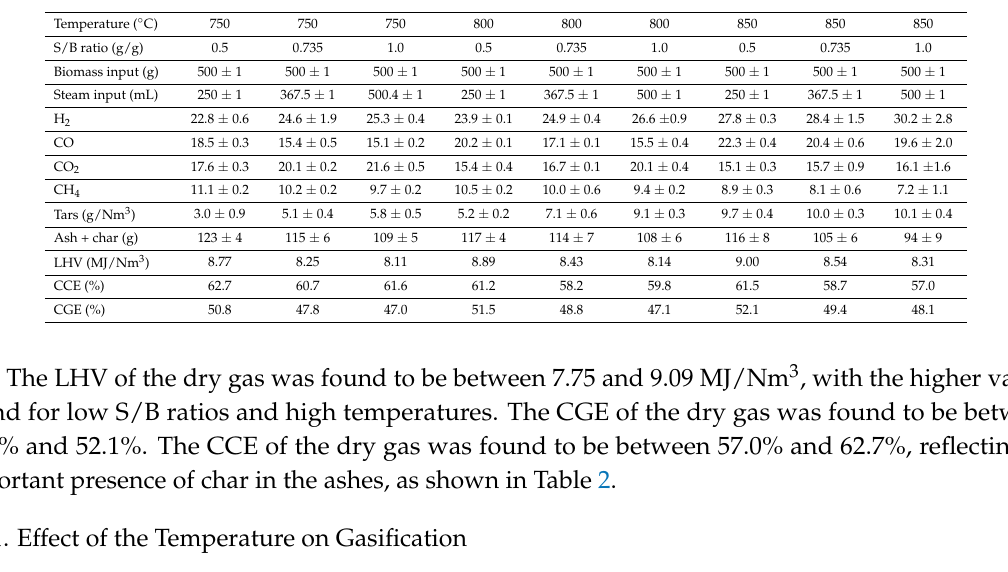
Table 2. Results of the gas measurements.